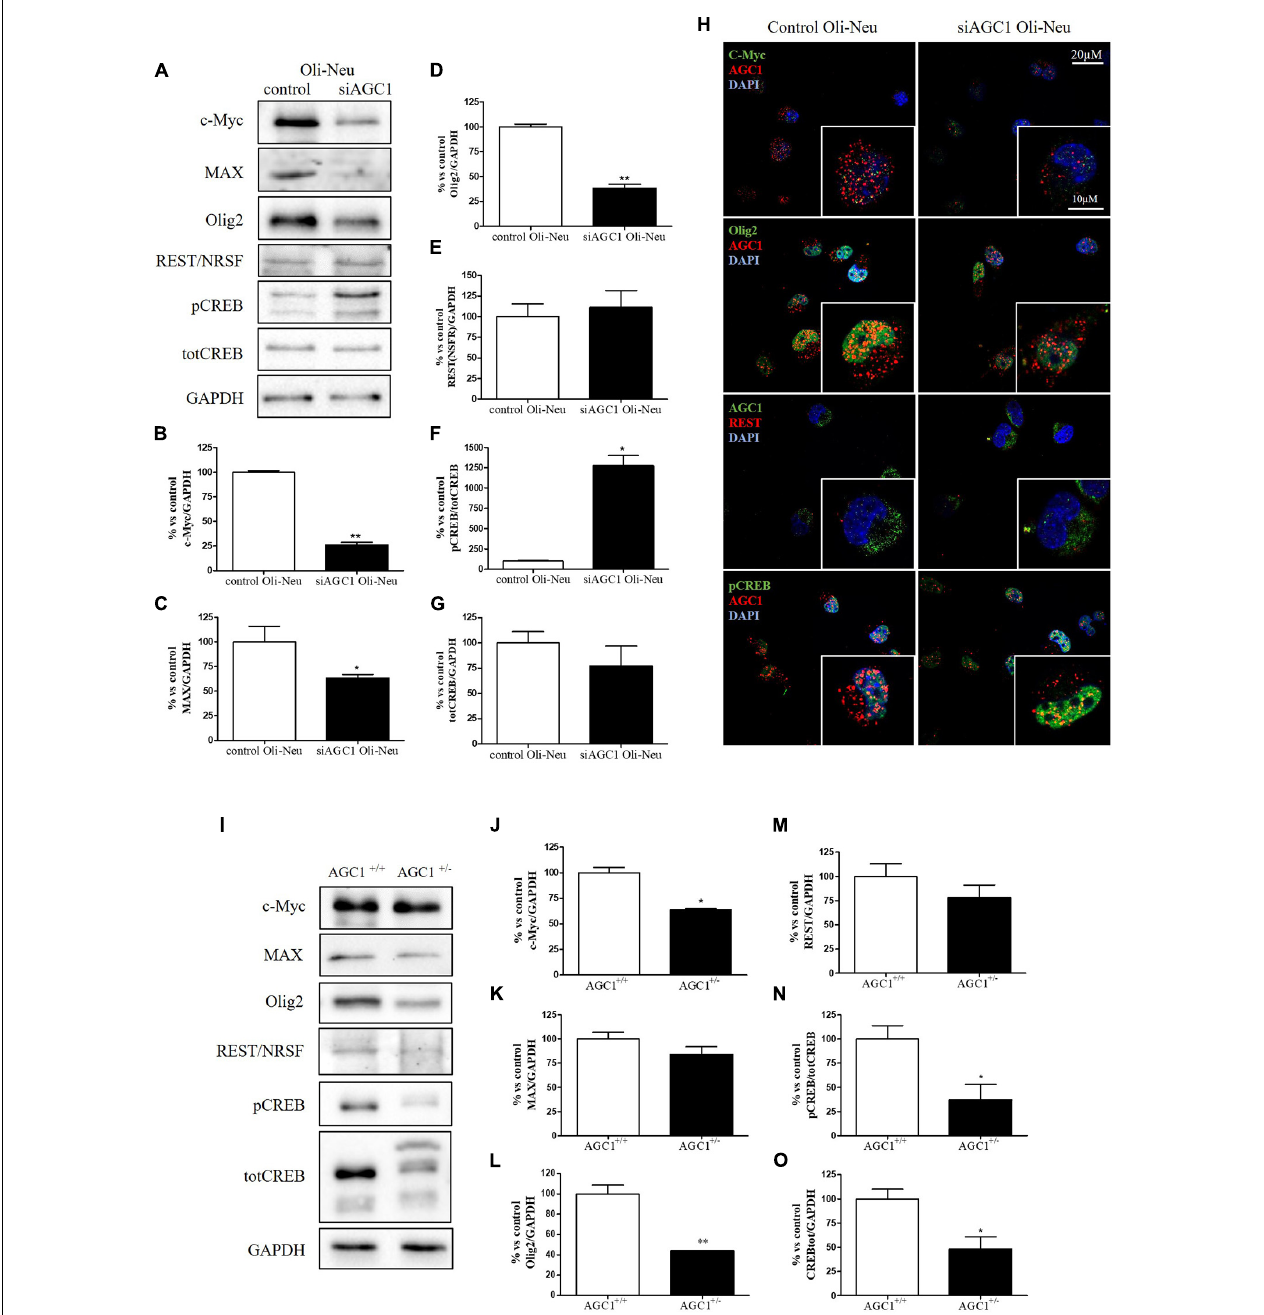
FIGURE 2 | Different expression of proliferation/differentiation transcription factors characterizes both Oli-Neu and neurospheres AGC1 deficiency in vitro models. WB and relative densitometries of c-Myc (A,B) , MAX (A,C) , Olig2 (A,D) , REST (A,E) , pCREB (A,F) , and total CREB (A,G) expression in Oli-Neu cells; GAPDH was used for endogenous normalization. Confocal microscopy images (100X) of the transcription factors (H) in Oli-Neu cells; nuclei were labeled with DAPI. Scale bars: 20 and 10 µ m. WB analysis and relative densitometries of c-Myc (I,J) , MAX (I,K) , Olig2 (I,L) , REST (I,M) , pCREB (I,N) , and total CREB (I,O) expression in neurospheres; GAPDH was used for endogenous normalization. Values are mean ± SD of at least 3 independent experiments; ** p < 0.01, * p < 0.05, compared to controls; Student’s t -test.